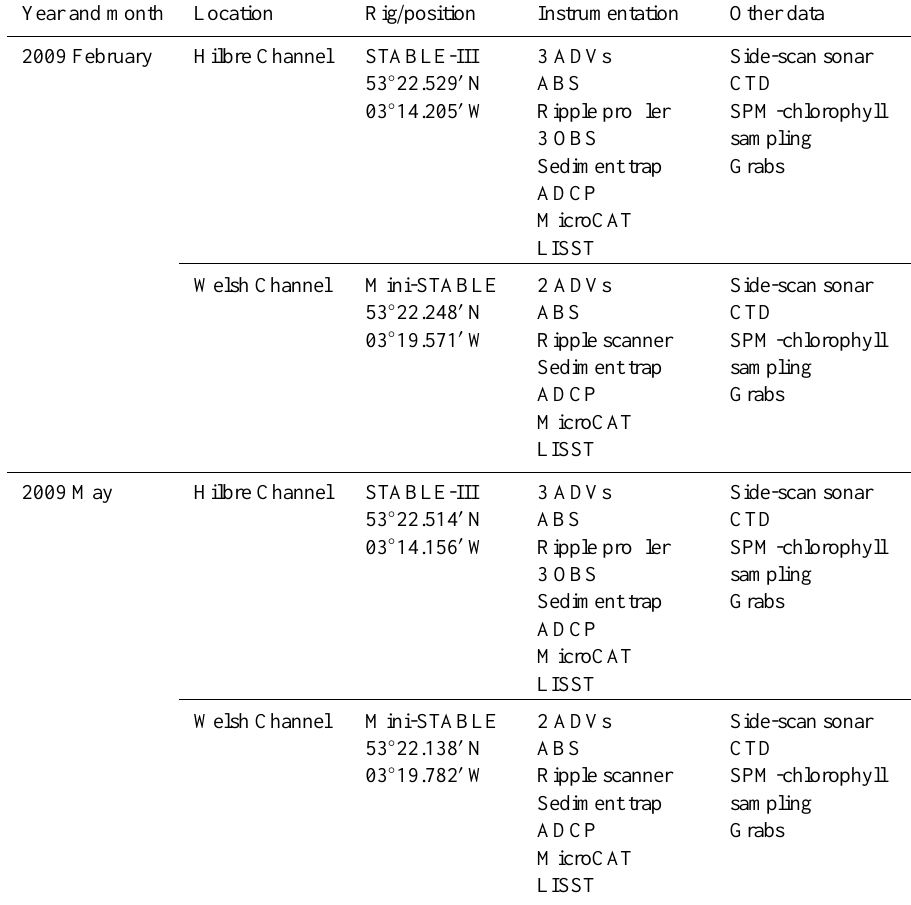
Table 7. Summary of the 2009